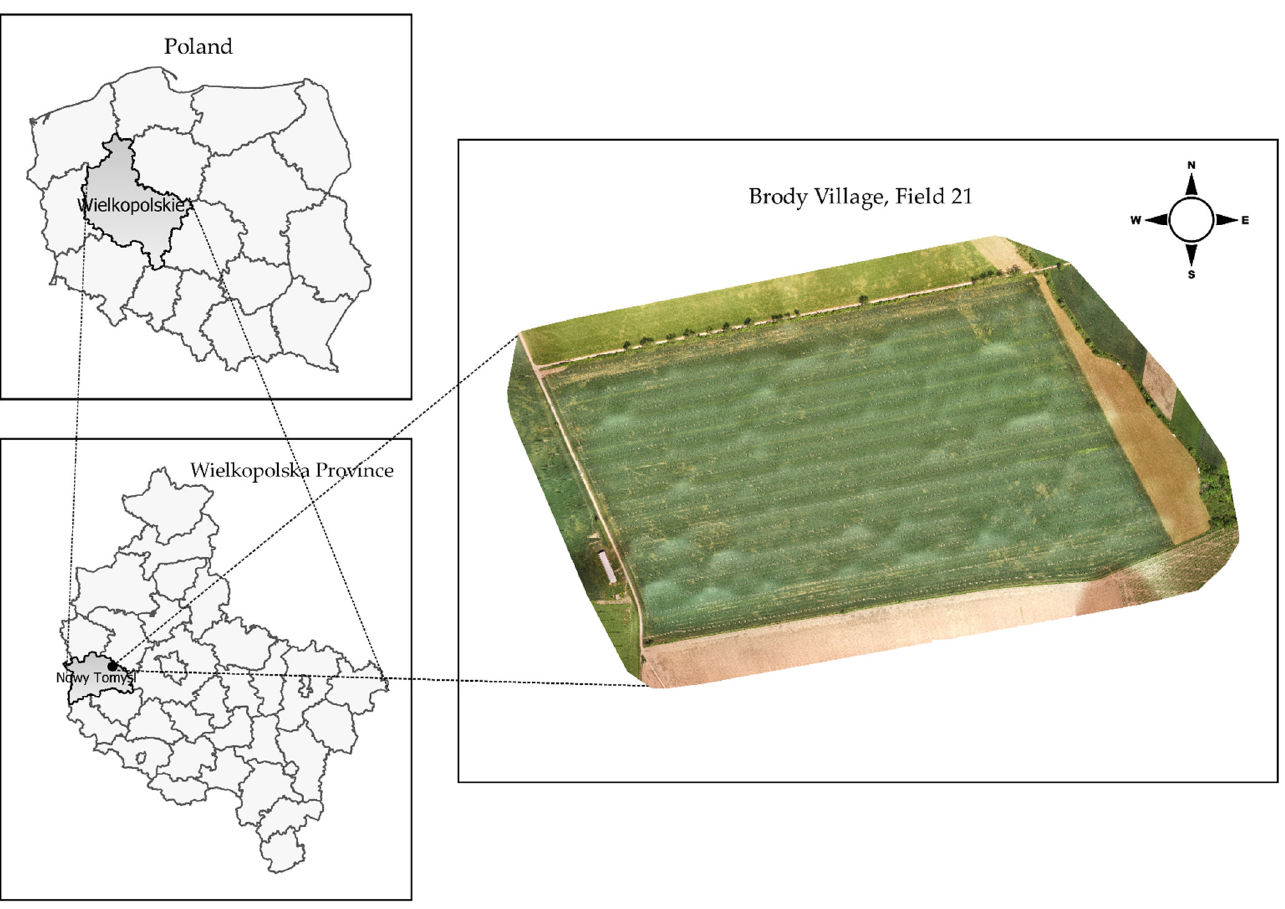
Figure 1. The geographic location of the study area in Brody, Wielkopolska province, Poland.